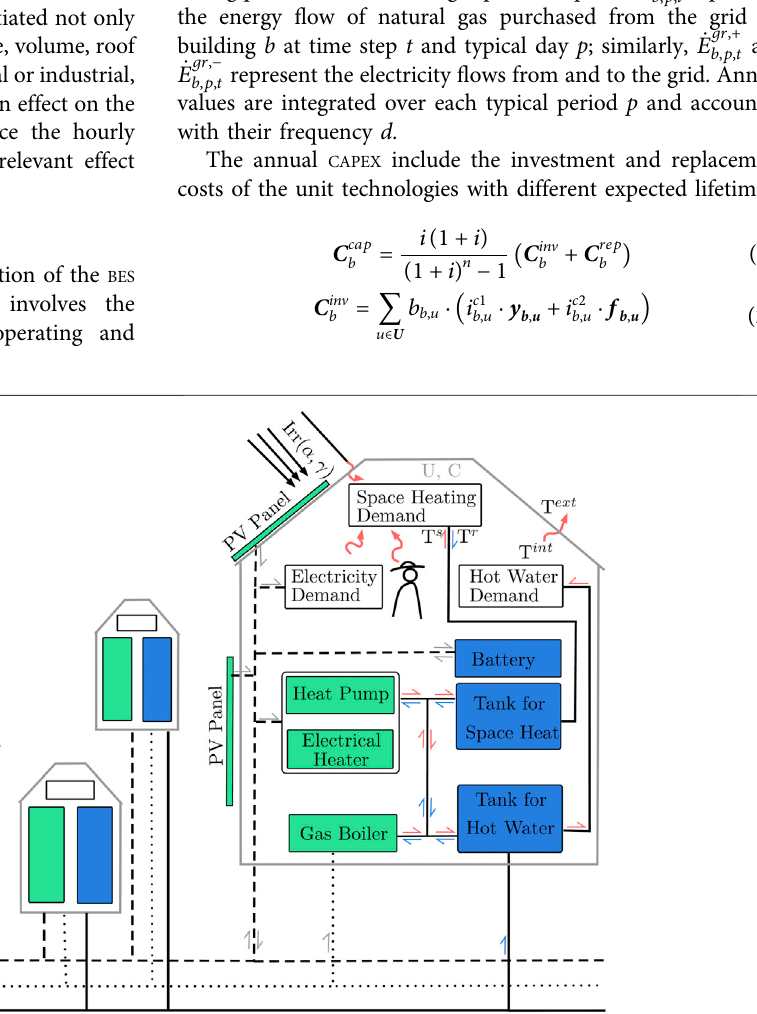
Frontiers in Energy Research |